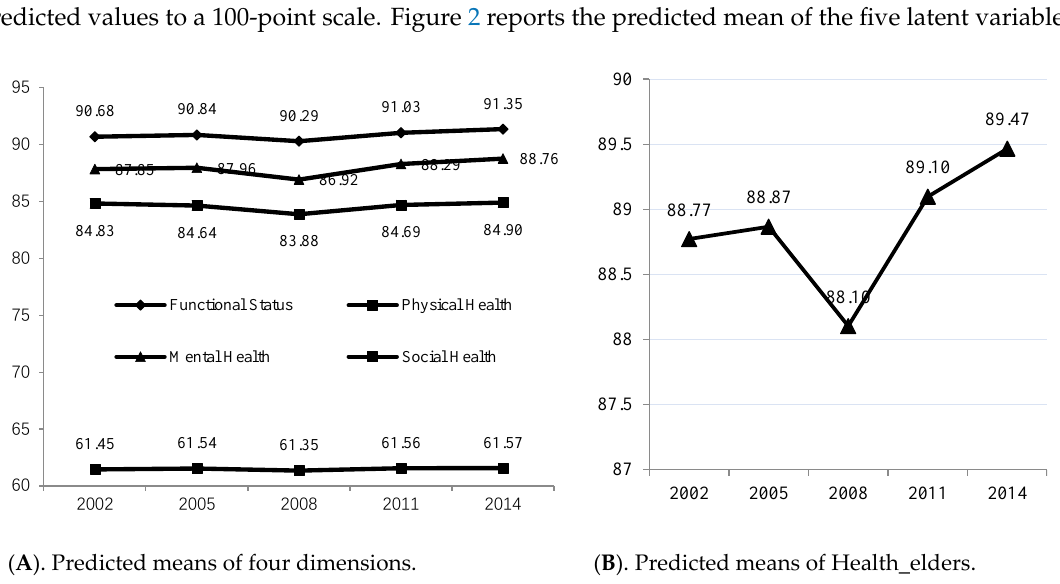
Figure 2. Predicted mean values of Health_elders and the four dimensions in five periods.